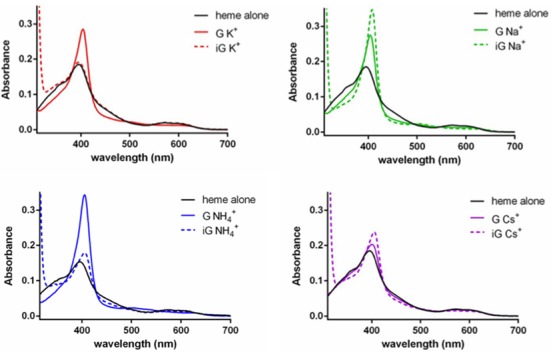
UV-vis spectra of 0.5-μM solutions of monomeric heme, following incubation with specific multi-stranded complexes formed by 5′-T8G4T (‘G’) and by 5′-T8iG4T (‘iG’) in buffered solutions containing, respectively, NaCl, KCl, NH4Cl and CsCl.